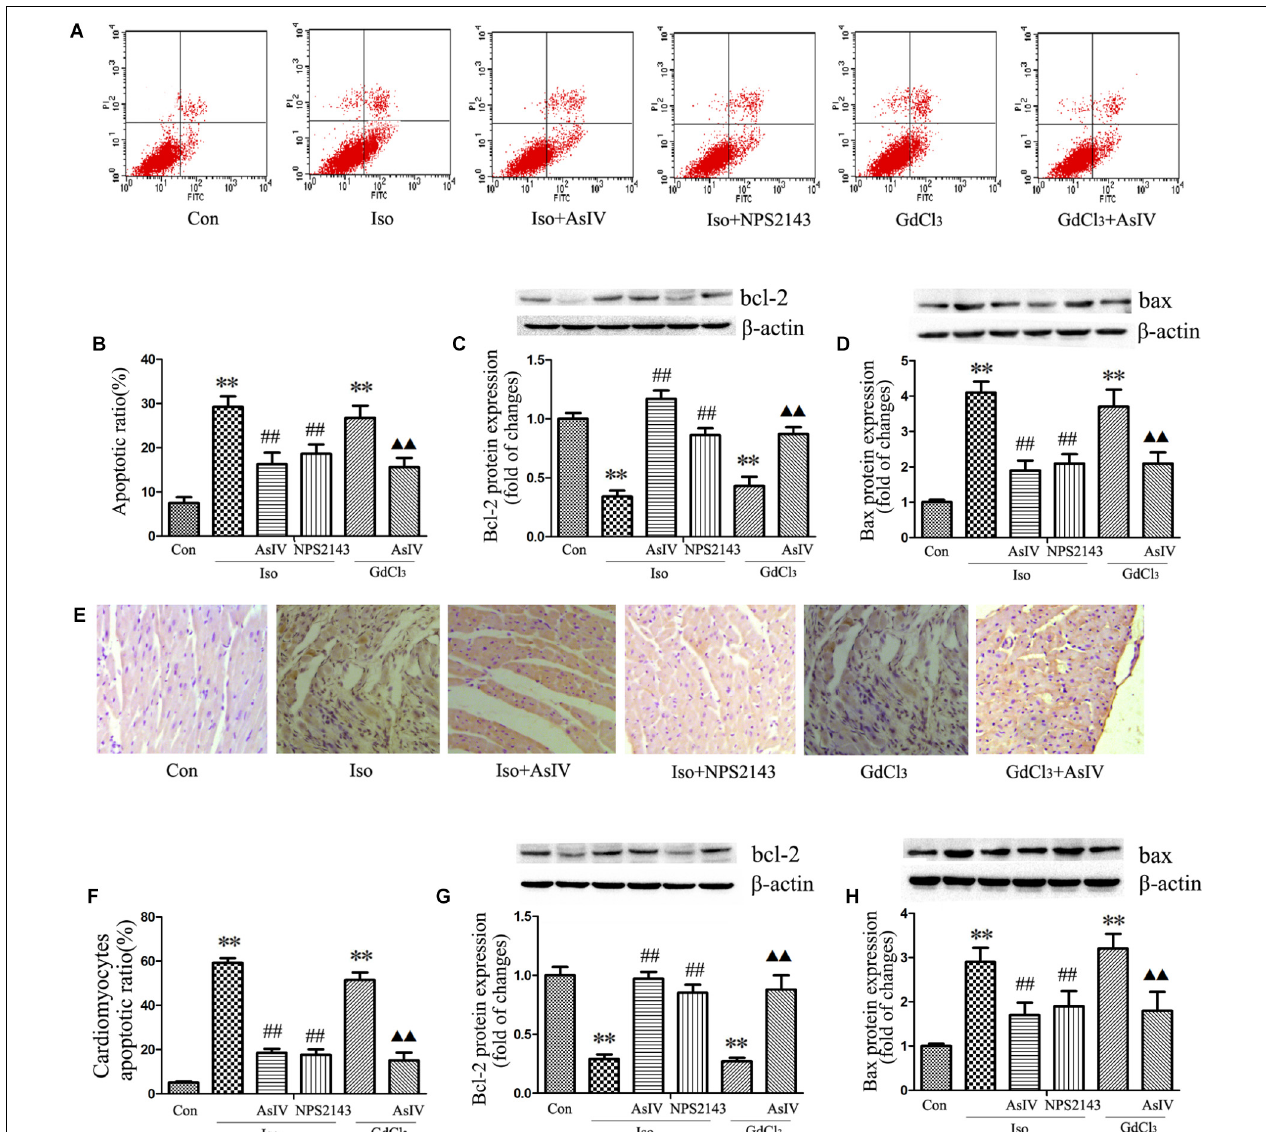
FIGURE 3 | AsIV inhibited apoptosis in hypertrophied heart tissue and cells. (A,B) The level of apoptosis in H9C2 cells was examined using Annexin-V/PI staining and flow cytometry. The upper right area and the lower right area were regarded as apoptotic areas. (C,D) Bax and Bcl-2 protein expression assayed by western blot analysis in H9C2 cells. (E,F) Myocardial apoptosis assayed by TUNEL staining. TUNEL-positive cells were manifested as a marked appearance of dark brown apoptotic cell nuclei. (G,H) Bax and bcl-2 protein expressions assayed by western blot in myocardial tissue. The data are expressed as the means ± SEM, n = 4. ∗∗ P < 0.01 vs. the Con group; ## P < 0.01 vs. the Iso group; and (cid:78) P < 0.05, (cid:78)(cid:78) P < 0.01 vs. the GdCl 3